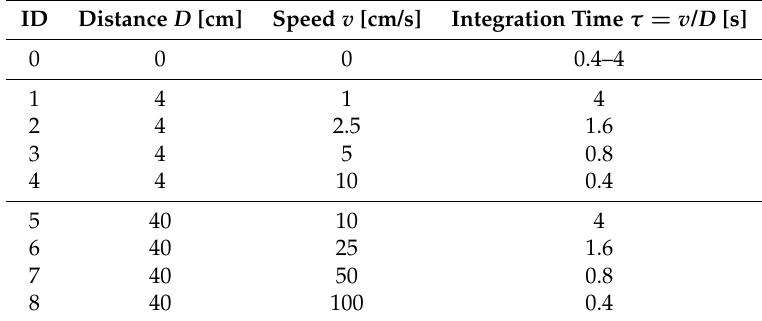
Table 2. Range of motion conditions for the eight designed experiments: four integration times to measure short and range distances, with increasing average